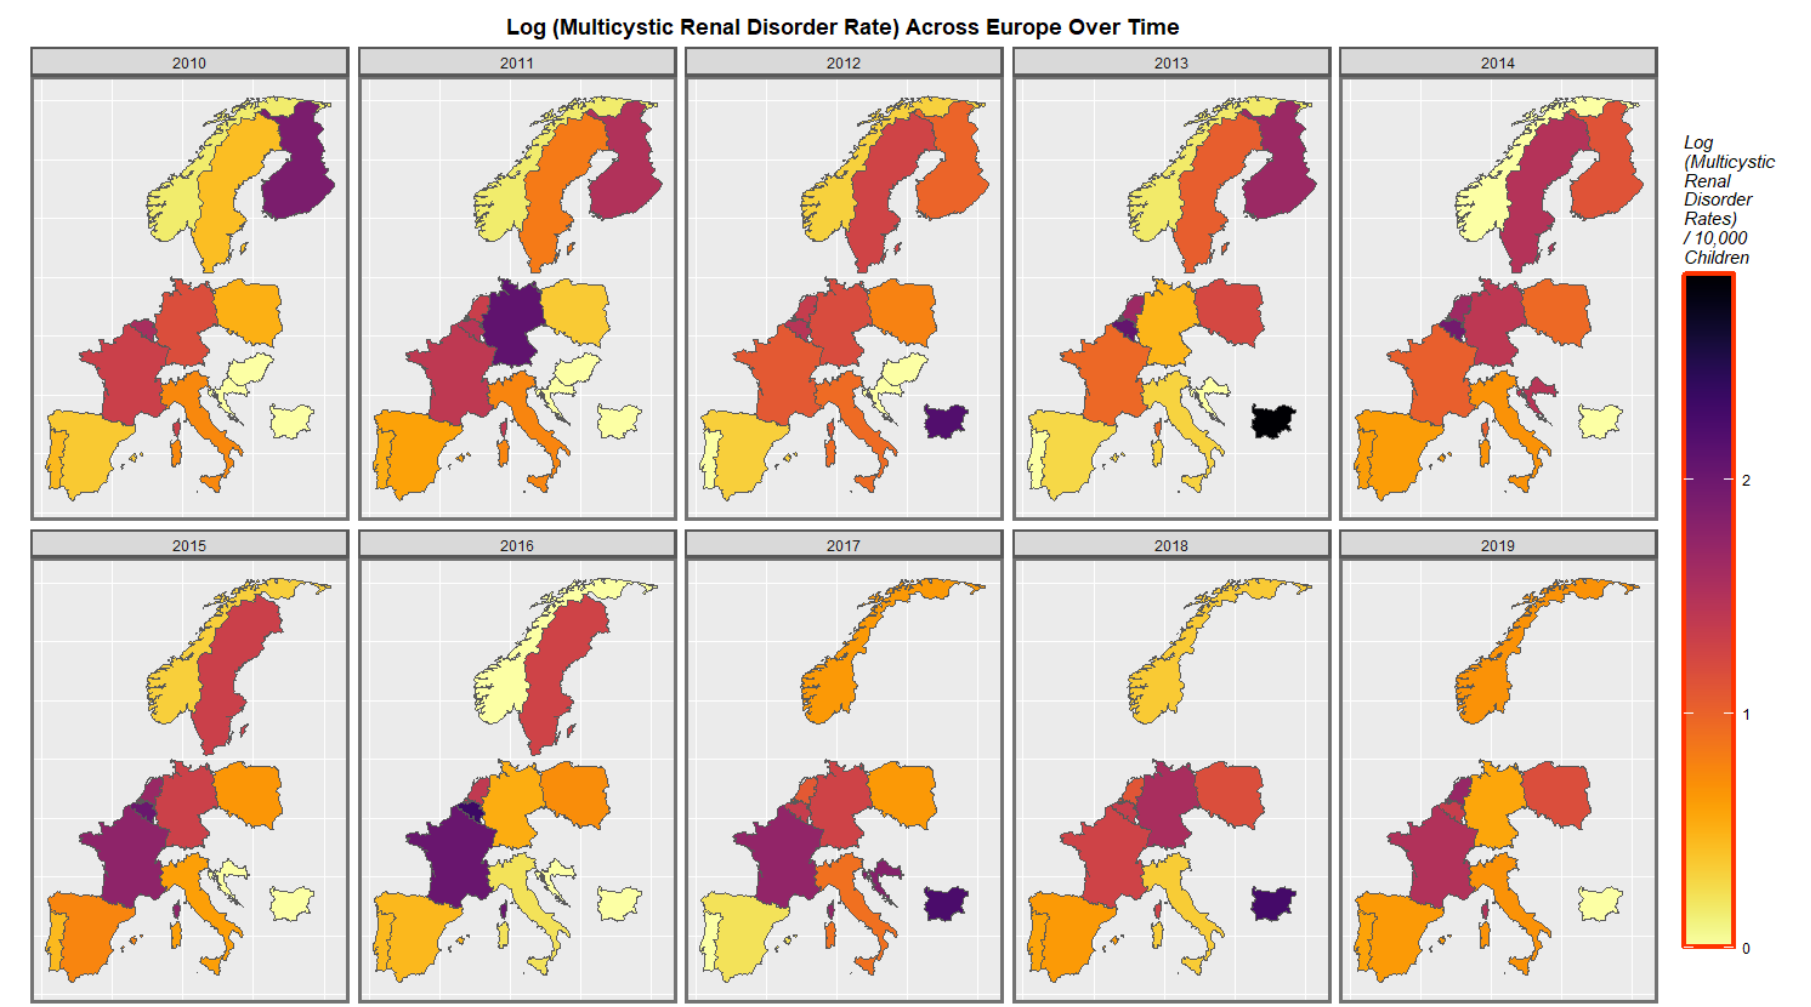
Figure 6. Time sequential map-graph of log (Multicystic renal disease rate) across surveyed European nations over time.